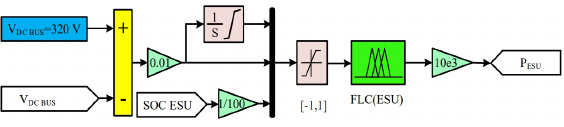
Fig. 2. FLC for ESU power